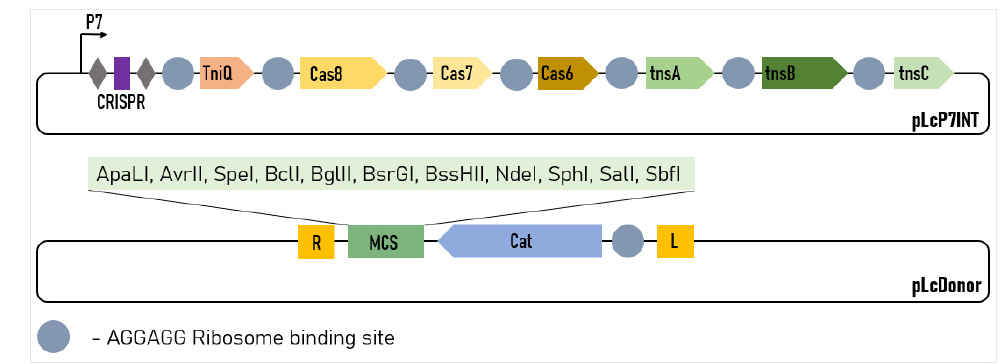
Figure 2. Design of the two-plasmid L. lactis genome-editing system. The CRISPR array comprises two repeats (grey diamonds) and a single spacer (purple rectangle). R and L represent the left and right transposon shoulders,